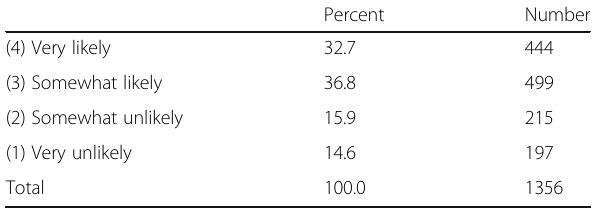
Table 4 Likelihood of choosing a STEM career